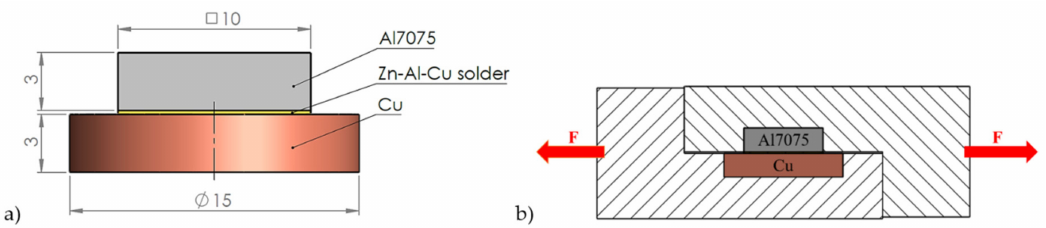
Figure 4. Schematic presentation of shear strength measurement. ( a ) Specimen for shear strength test (unit: mm); ( b ) scheme of special